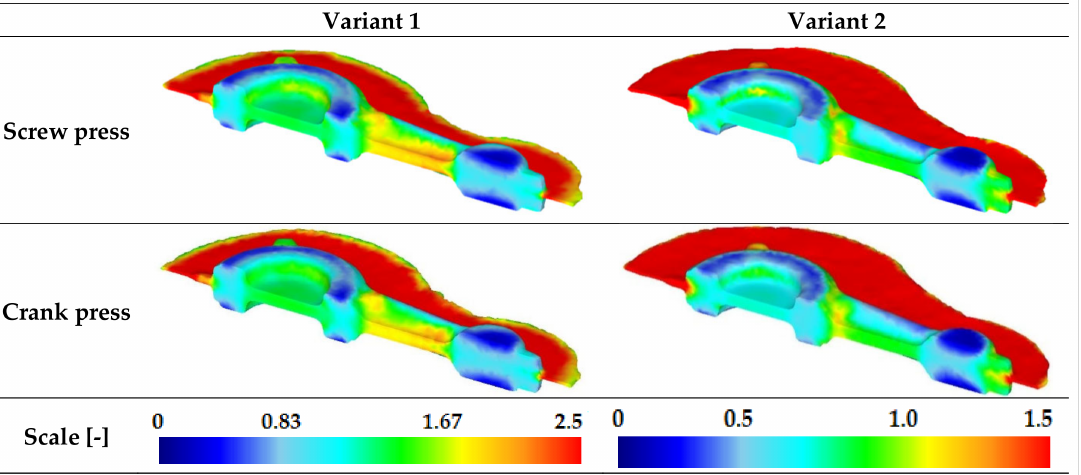
Figure 18. Distribution of effective strain for connecting rod forgings made of AB-71100 aluminum alloy formed based on the new